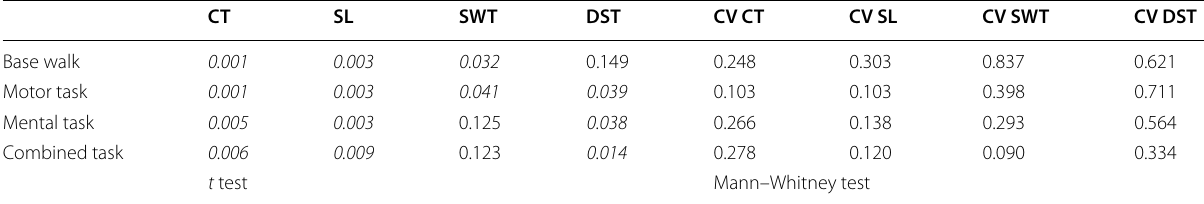
Table 2 Between group comparisons (FM vs HC) of gait parameters for all experimental conditions